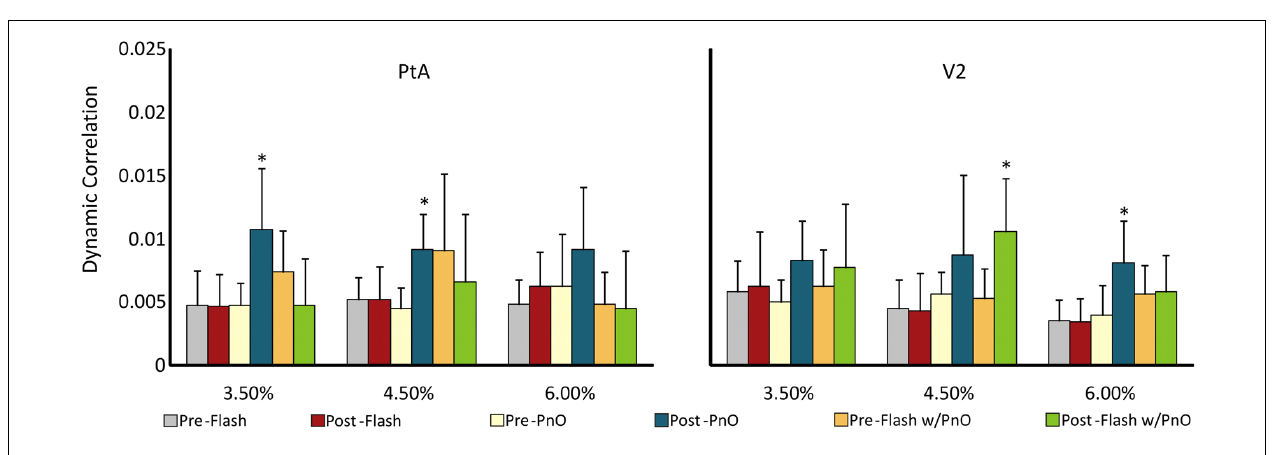
concentrations, and only at 6% inV2. Light flashes presented after PnO stimulation augmented dynamic spike correlation inV2 at the intermediate desflurane concentration. * p < 0.05 post vs. pre. Error bars are ± 1